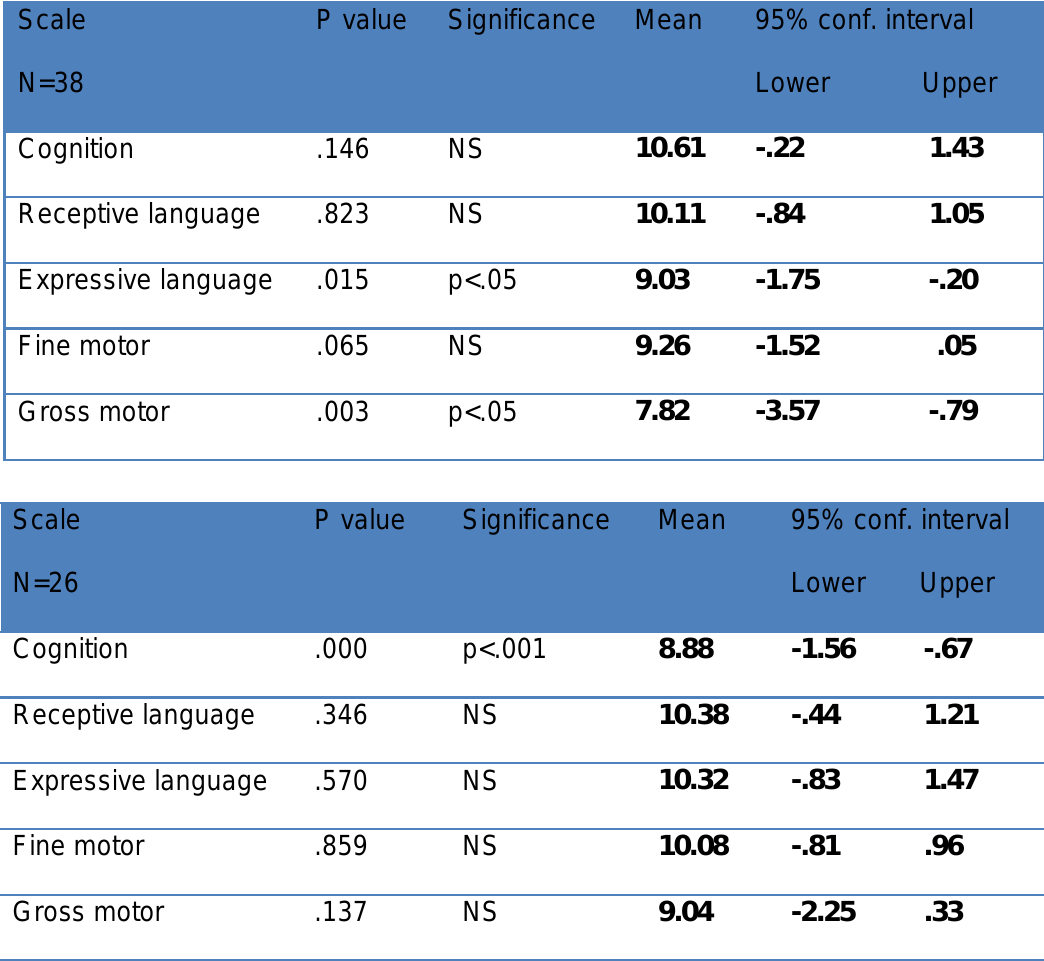
Table 2: Comparison of developmental assessments at 1 year and 3 years of age Scale